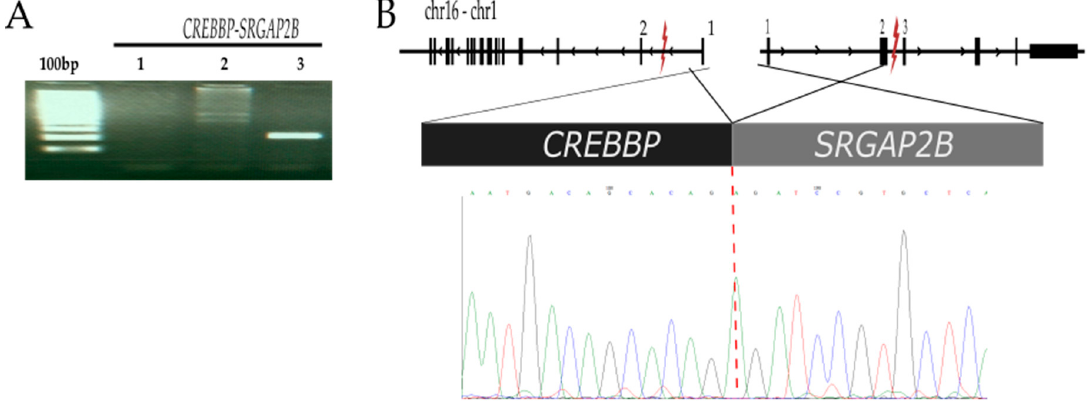
Figure 1. Characterization of the CREBBP-SRGAP2B gene fusion. ( A ) 100 bp marker, PCR of CREBBP-SRGAP2B using H 2 0 as negative control (lane1), DNA genomic (lane 2), and cDNA from total RNA isolated from 74MO sample (lane 3). ( B ) Schematic diagram showing the structure of CREBBP-SRGAP2B fusion, exon 1 of the CREBBP gene is fused in frame with exon 3 of the SRGAP2B gene. The symbol “lightning” indicates the breakpoint region. A CREBBP-SRGAP2B fusion sequence is shown below, with a schematic derived by the cloning and sequencing of the RT-PCR product.